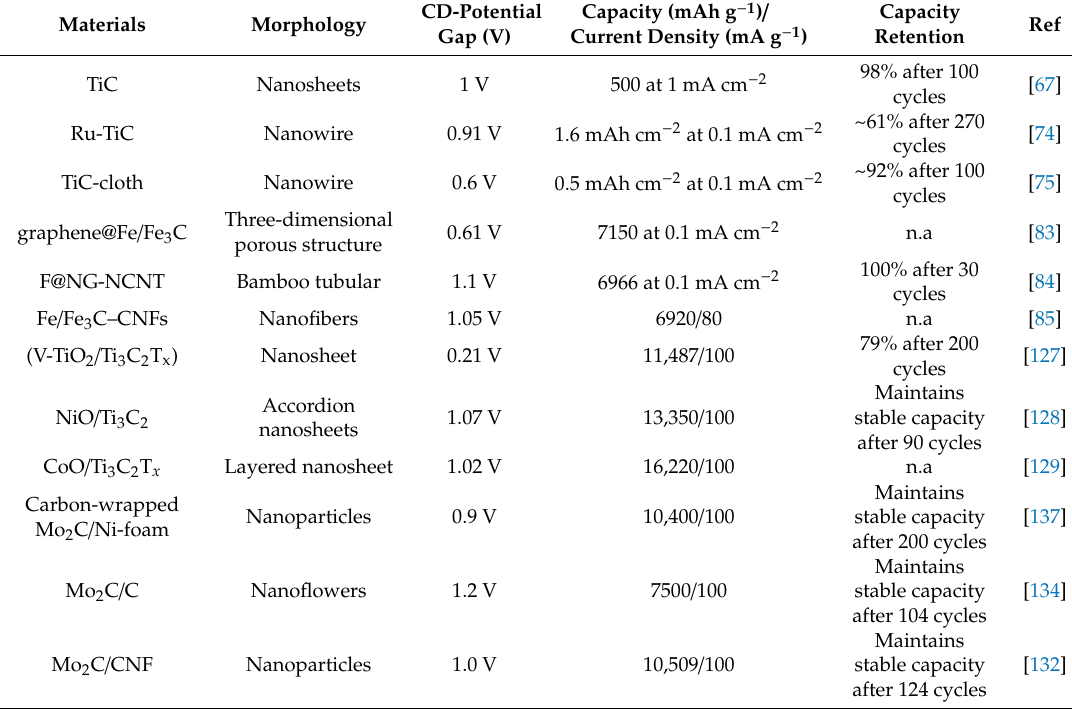
Table 1. Electrochemical and storage performance of TMC- and TMN-based cathode electrocatalysts for